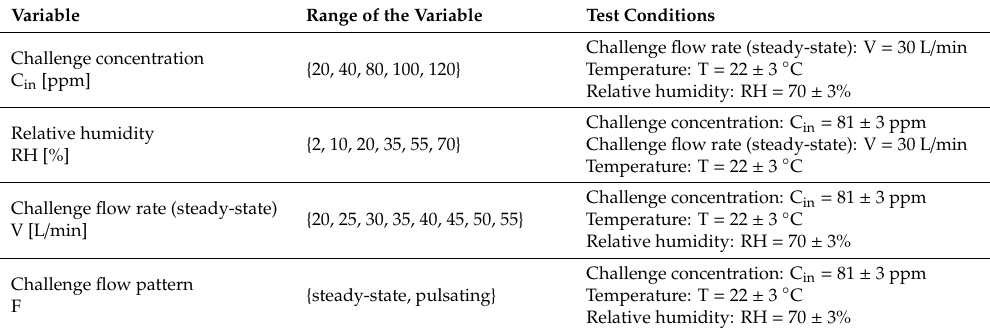
Table 1. Testing